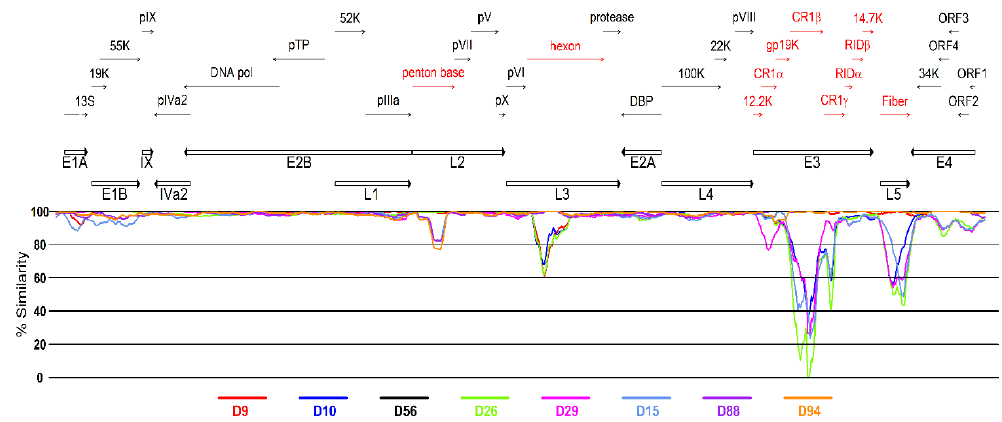
Figure 4. Analysis of genomic sequences for regions of divergence and similarity. The similarity plot was generated using the whole genome sequence comparing the consensus sequence for all HAdV-D56 strains included in the analysis as a query against various selected genotypes (D9, D10, D15, D26, D29, D88, and D94). The plot represents the percent similarity in a 500-nucleotide sliding window and a 50-nucleotide step size with gapped sites removed. Color codes are shown at the bottom of the panel. Regions encoding proteins that were further examined in the proteotyping analysis are colored in red.